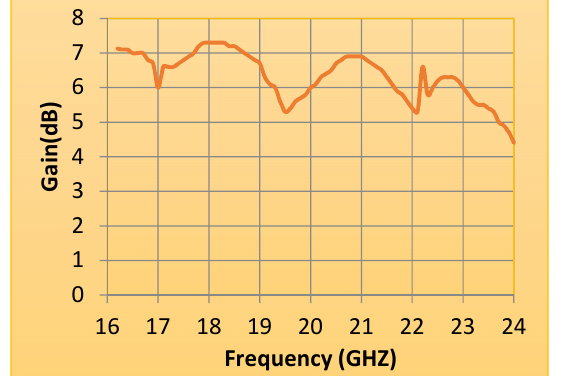
FIG. 10. GAIN OF THE SIMULATED STRUCTURE 4. CHANGES IN THE STRUCTURE Some changes were incorporated in the above structure which resulted in the expansion of the BW and the changes were highlighted in Fig. 11. Another feeding mechanism was employed here which is named as inset fed line.